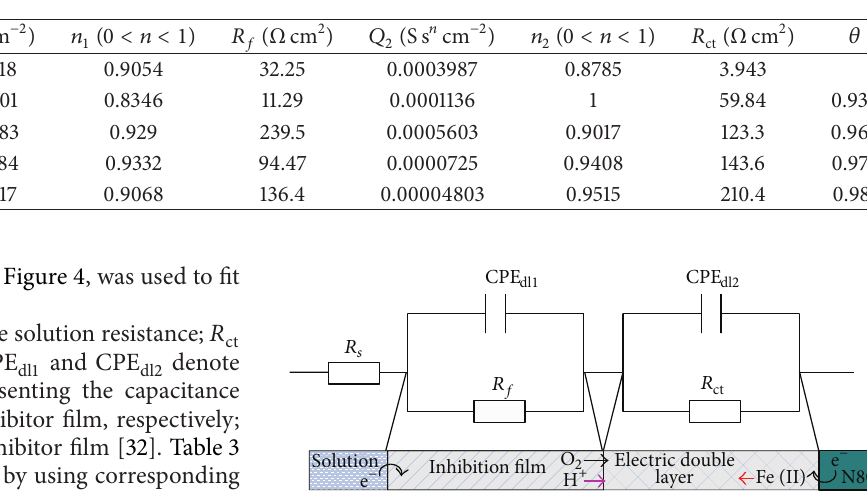
Table 3: Electrochemical parameters calculated from EIS measurements on N80 electrode in 15% HCl solution for different corrosion inhibitor concentrations at 25 ± 1 ∘ C.